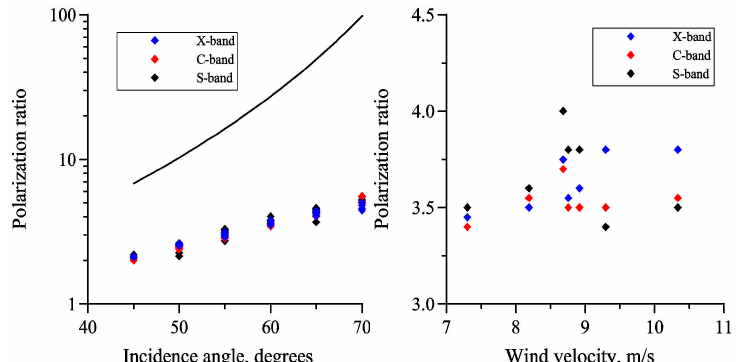
Figure 3. Experimental values of the mean PR vs. radar incidence angle ( left ) and vs. wind velocity ( right ) obtained from measurements with the three-band radar for clean water in X-, C- and S-bands (blue, red and black symbols, respectively). The curve is PR calculated according to two-scale Bragg theory [1]. Wind velocities range is 7 m/s to 10 m/s, radar azimuth angles vary from zero to ±30°, that is, close to upwind directions.